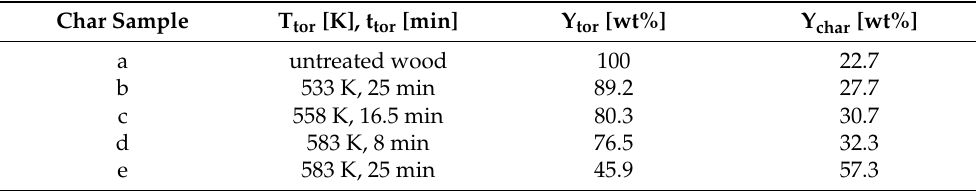
Table 1. Yields (wt%) of torrefied product, Y tor , and char from fixed-bed pyrolysis at 800 K, Y char , for spruce wood pre-treated at temperature, T tor , for holding time, t tor , [15,25]. Char